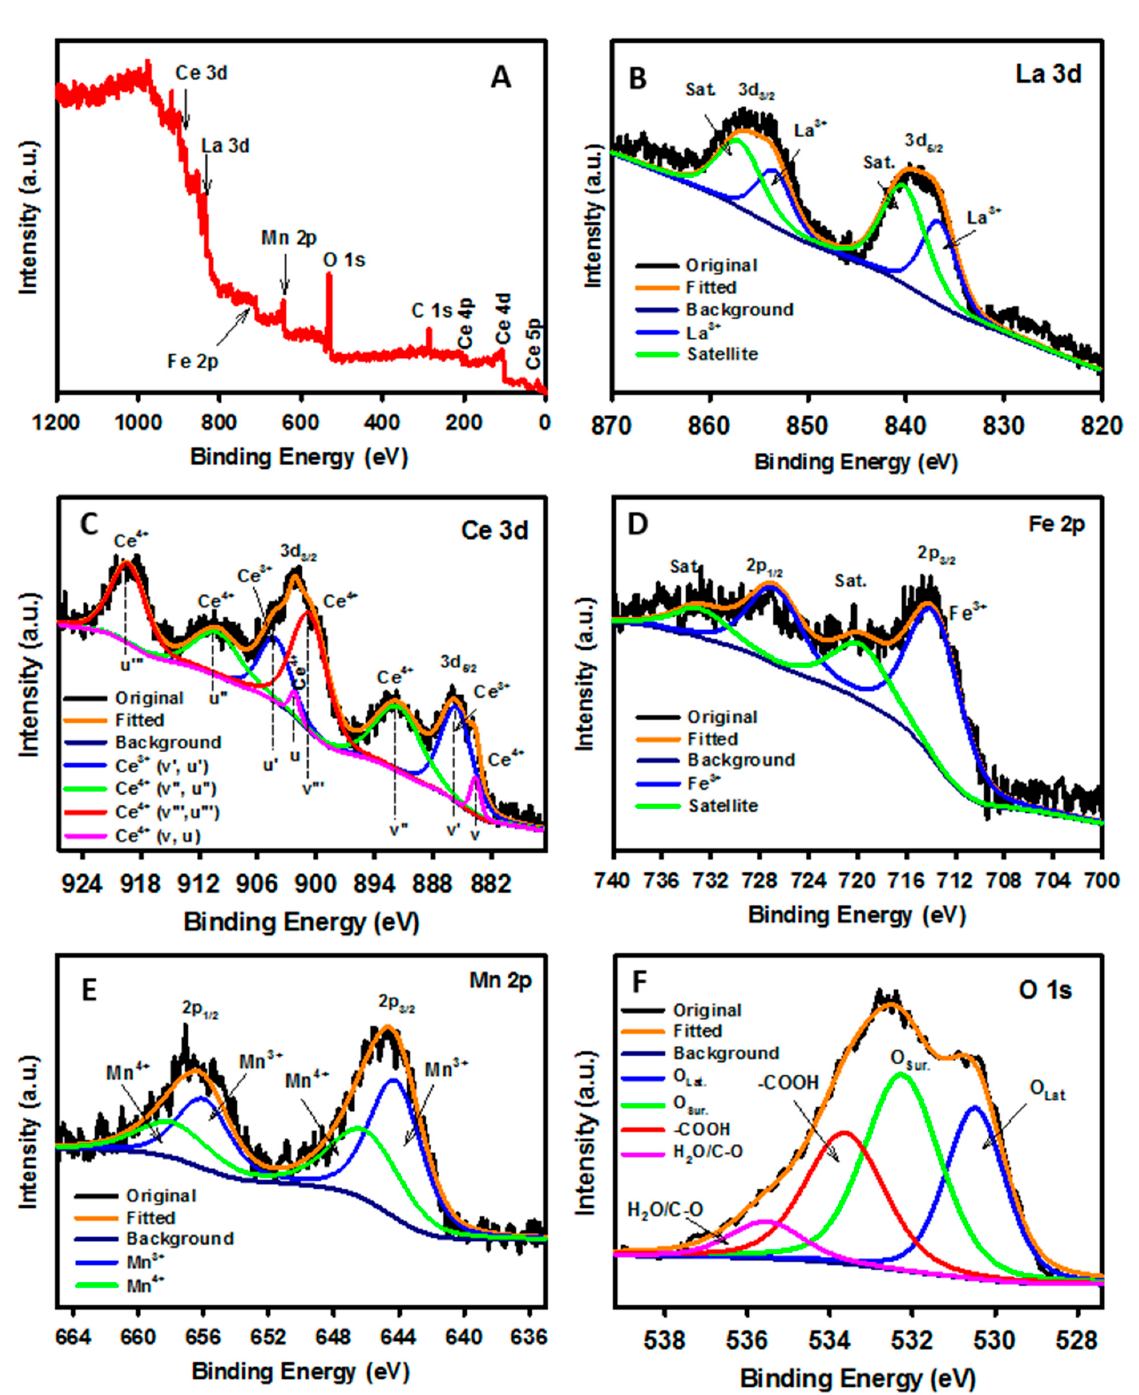
Figure 3. ( A ). XPS survey for elements present in LCFM(8255)-gly, deconvoluted XPS curves of ( B ) La 3d, ( C ) Ce 3d, ( D ) Fe 2p, ( E ) Mn 2p and ( F ) O 1s peak in LCFM(8255)-gly sample.